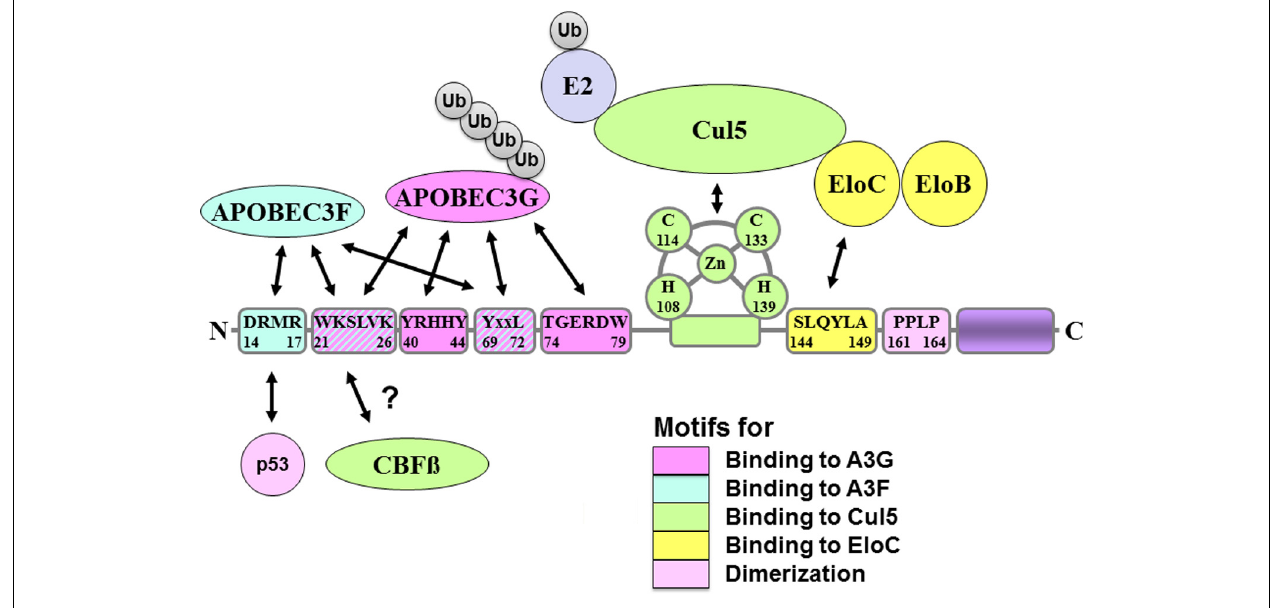
FIGURE 1 | Schematic figure of the virion infectivity factor (Vif) protein and amino acid motifs for binding toVif-interacting proteins. Pink indicates binding motifs for A3G; light blue indicates binding motifs for A3F;